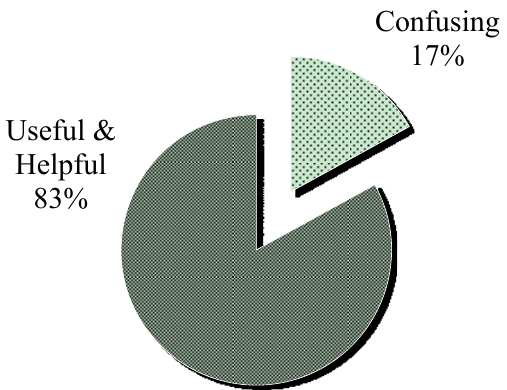
Figure 10. Graphical visualization of results of first part of the questionnaire (Q3).